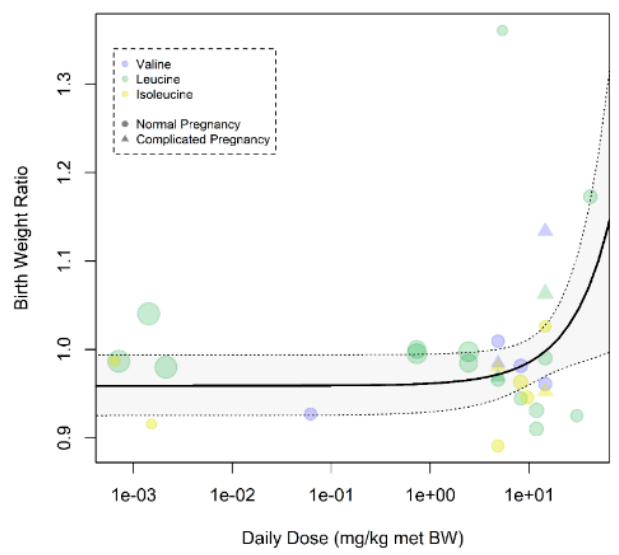
Figure A10. Dose-response curve on prenatal supplementation of branched chain amino acid (BCAA) on fetal/birth weight in all pregnancies. There was a dose-response effect in which the highest doses resulted in a larger improvement of birth weight ( p slope = 0.006). Only animal studies were included. Daily dose is expressed as mg per kg metabolic body weight.